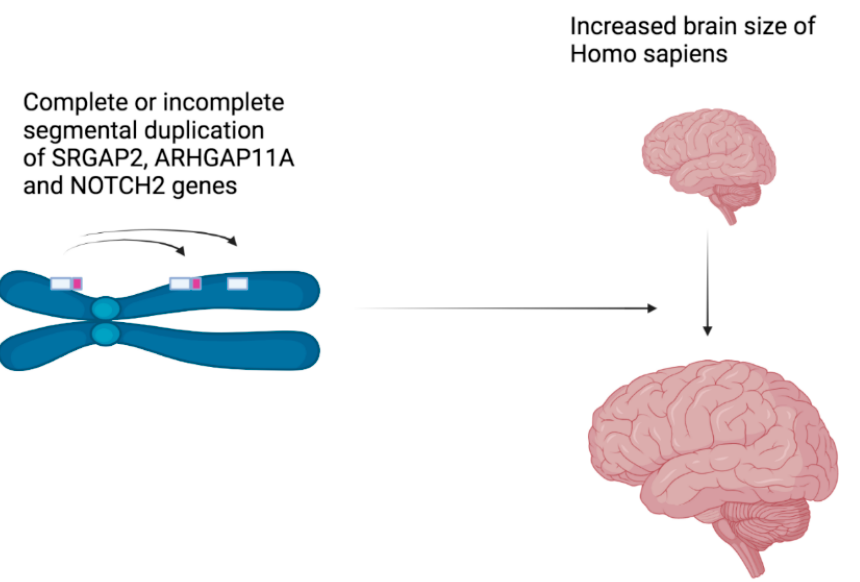
Figure 3. The partial or complete duplications of the SRGAP2, ARHGAP11A and NOTCH2 genes